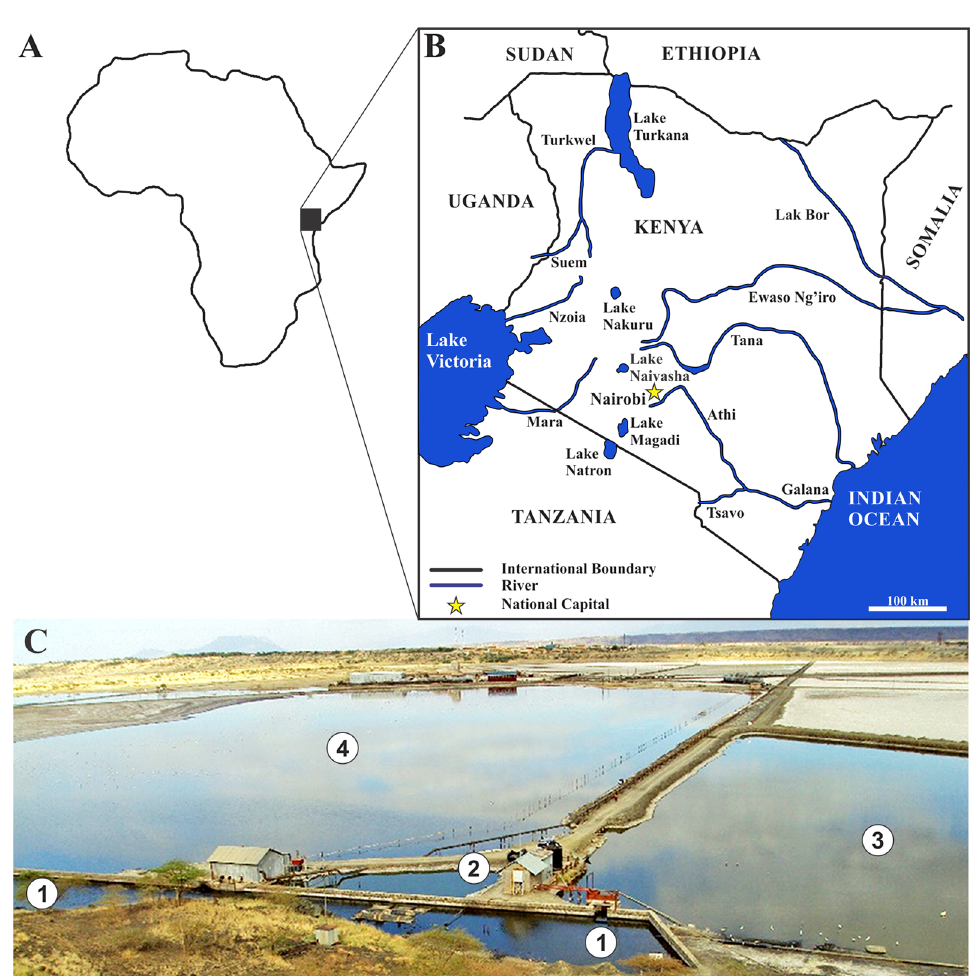
Figure 1. Collection sites from which Alcolapia grahami were collected. (A) Silhouette of Africa showing area of study; (B) map of study area indicating countries, water bodies, and relation of Lake Magadi to Nairobi; (C) fi sh spring lagoon of Lake Magadi from which the fi sh specimens were